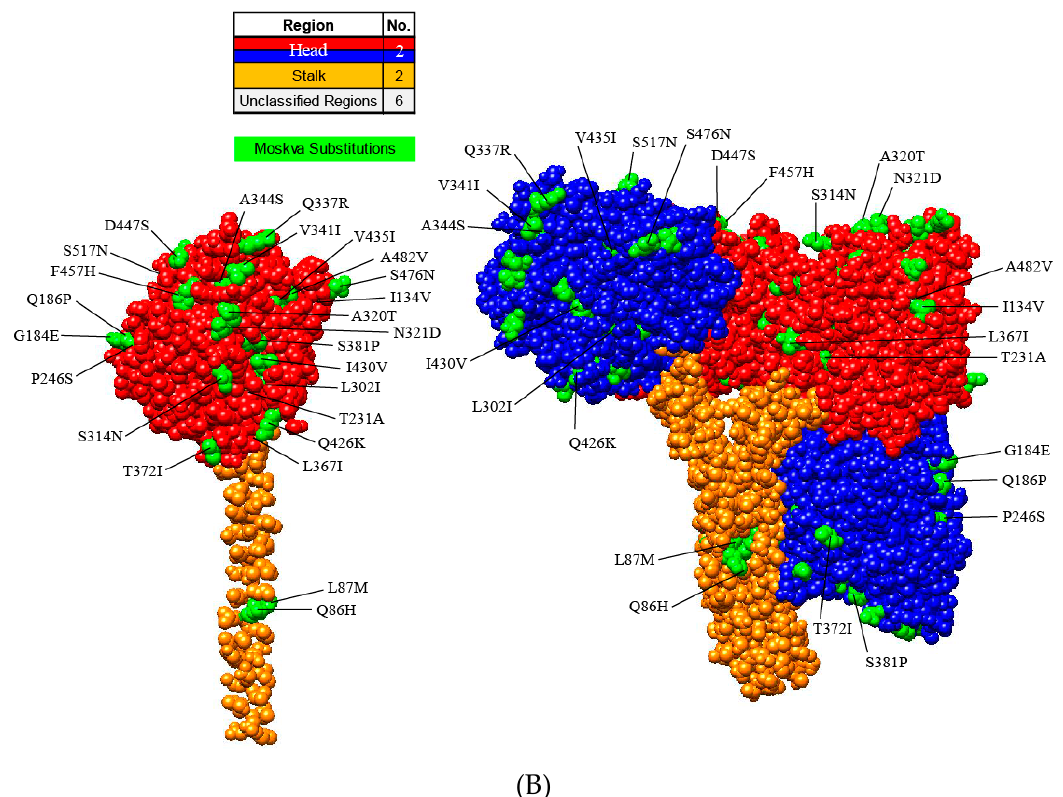
Figure 3. Protein models illustrating the residue substitutions in Moskva. Monomer and trimer models in uncleaved Fusion ( A ) and Hemagglutinin-neuraminidase (HN) ( B ) proteins. Regions and substitutions are colored according to the legend.